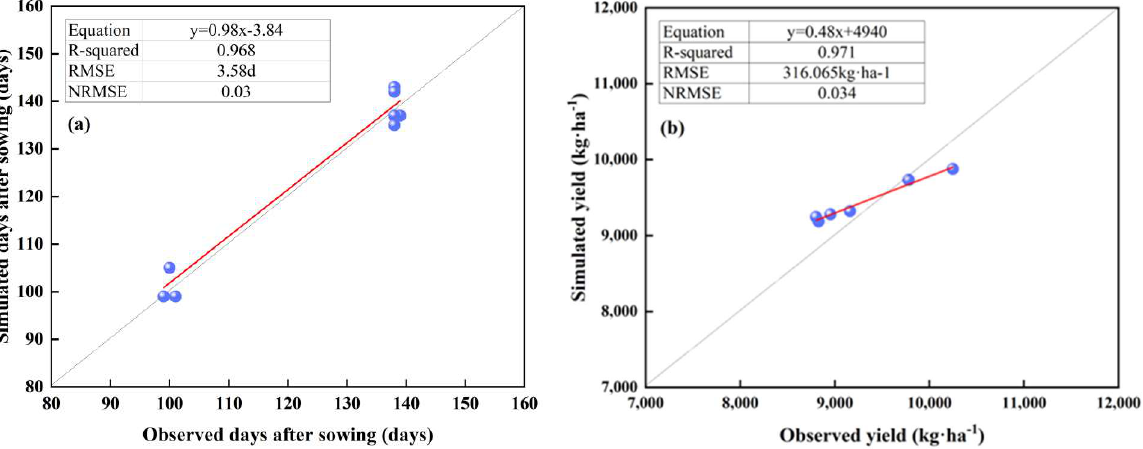
Figure 3. Verification results for the simulated and observed phenology and yield in the study field. The dots are simulated and observed values, the red line is the fitted line.